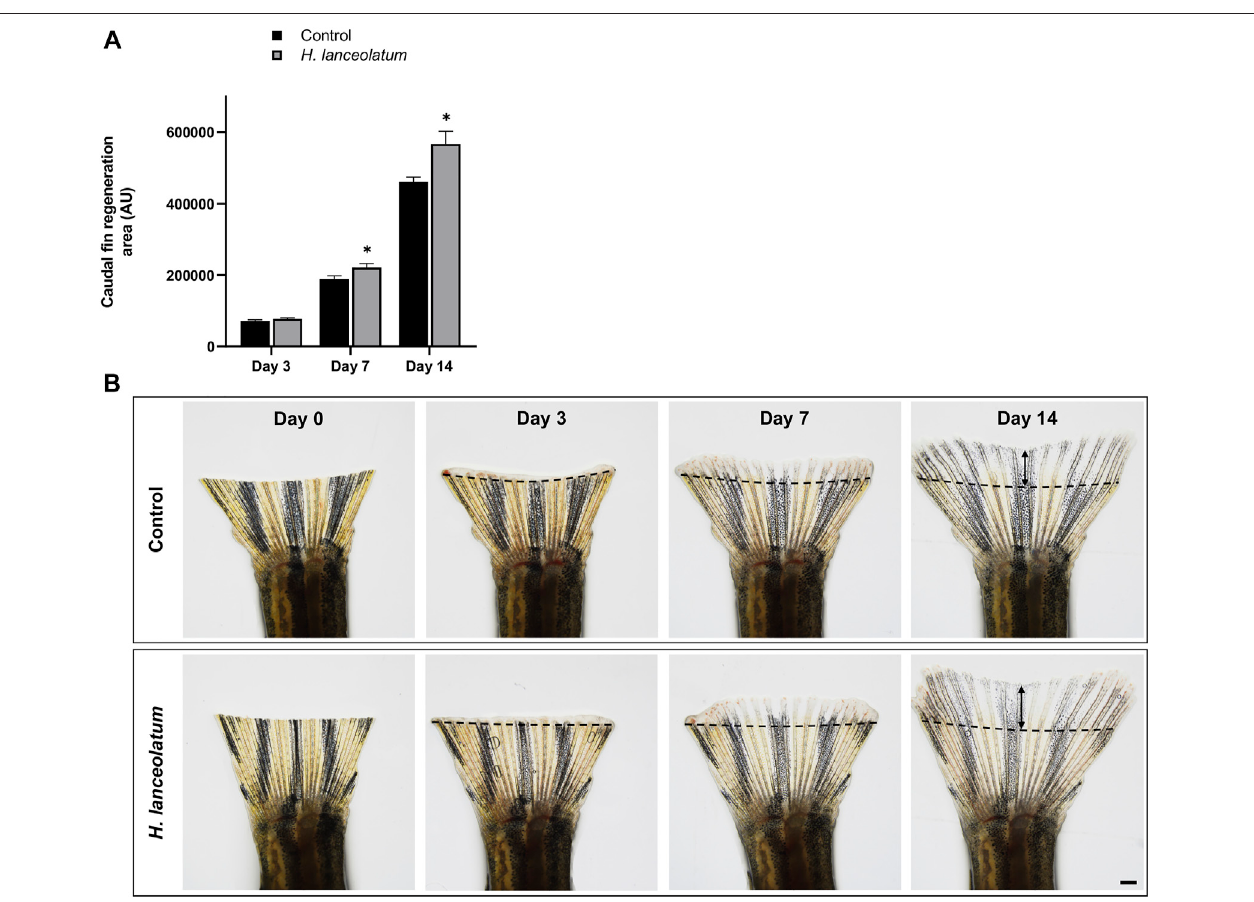
FIGURE9| H.lanceolatum aqueousextractdisplayspro-regenerativepropertiesinthetailofadult fi sh. (A) Measurementoftailregenerationareaofadult fi shaftera 14-days incubation period with fi sh water (Control) or H. lanceolatum aqueous extract at 0.3125 g/L ( H. lanceolatum ). (B) Representative pictures of caudal fi n regeneration3-,7-,and14-dayspost-amputation.Dottedlinesrepresentthetailamputationlevel.Resultsareexpressedasmeans±SEM(n=4 – 7animals/group).* p < 0.05, *** p < 0.001 (Student t-test). Bar = 625